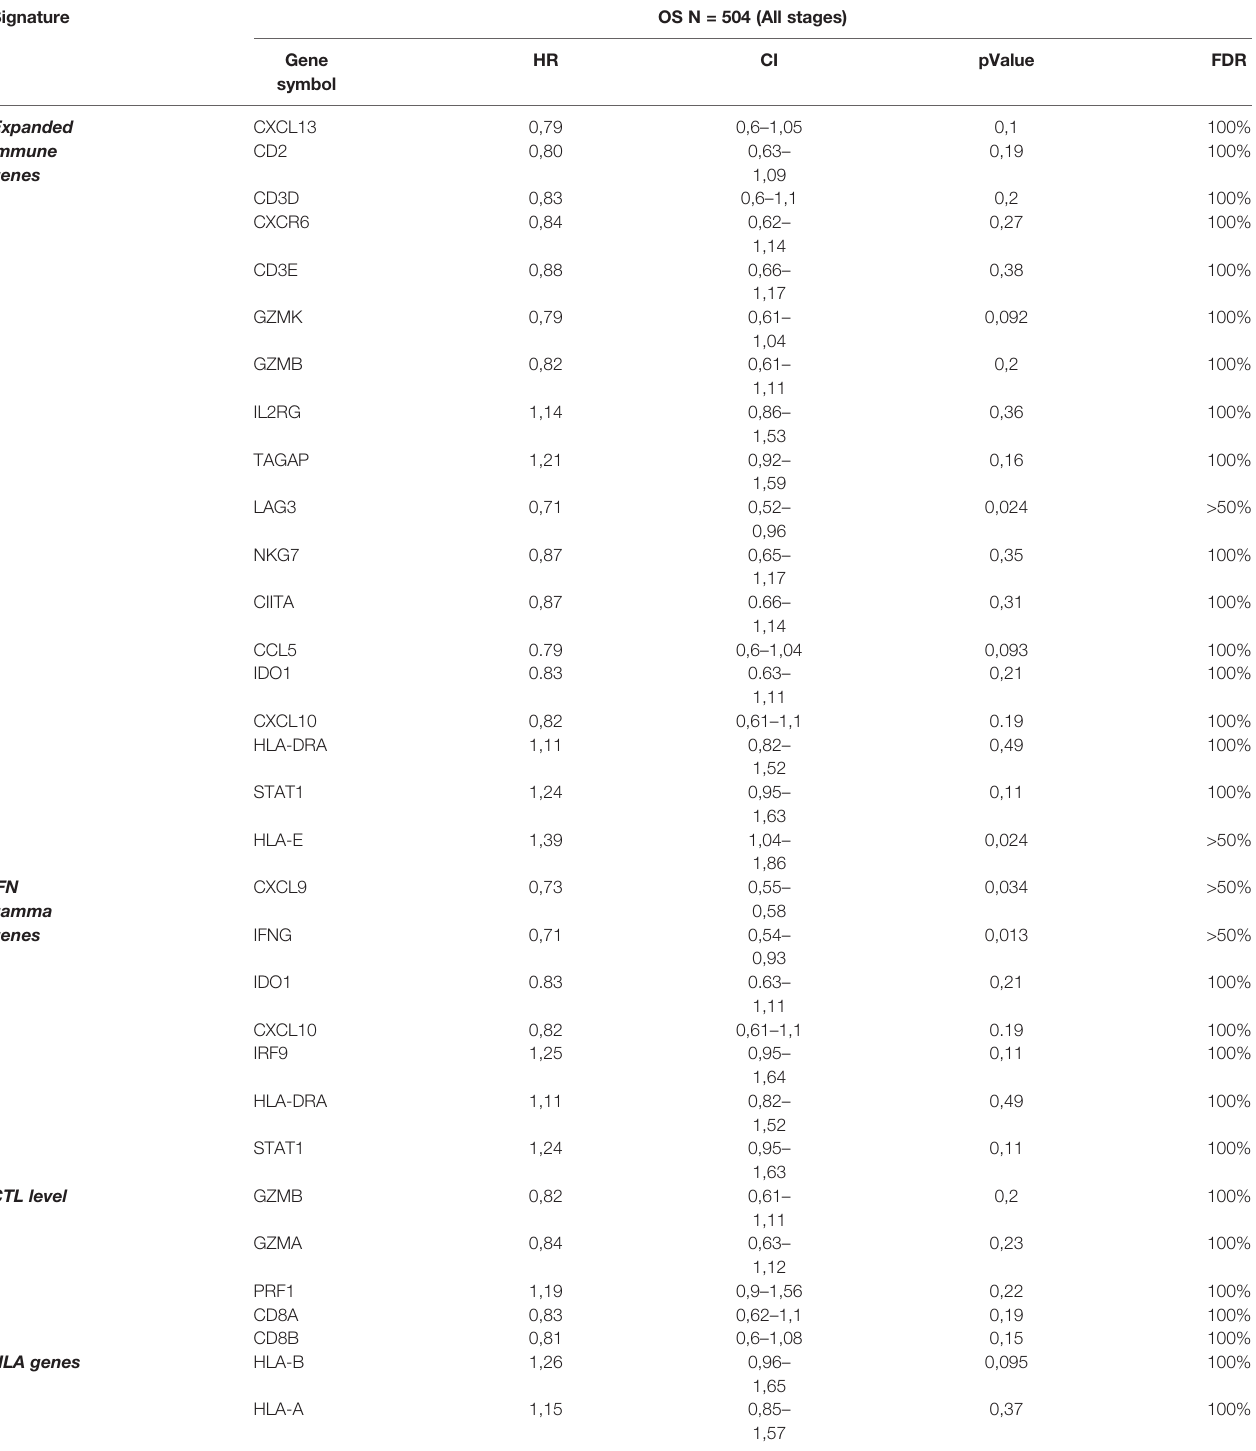
TABLE 3 | Clinical outcome of individual immune genes from the four immune gene signatures in terms of overall survival (OS) of LSCC patients.